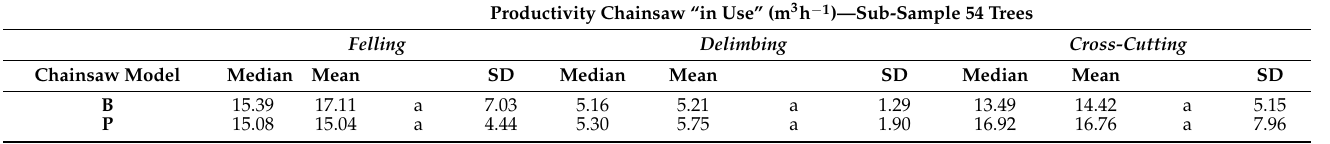
Table 7. Results of the productivity analysis per tree in single working phases (felling, delimbing, and cross-cutting), applied to each chainsaw model (B = battery MSA220 C-B; P = petrol MS201 C-M). Similar lowercase letters show the absence of a significant difference ( p value >